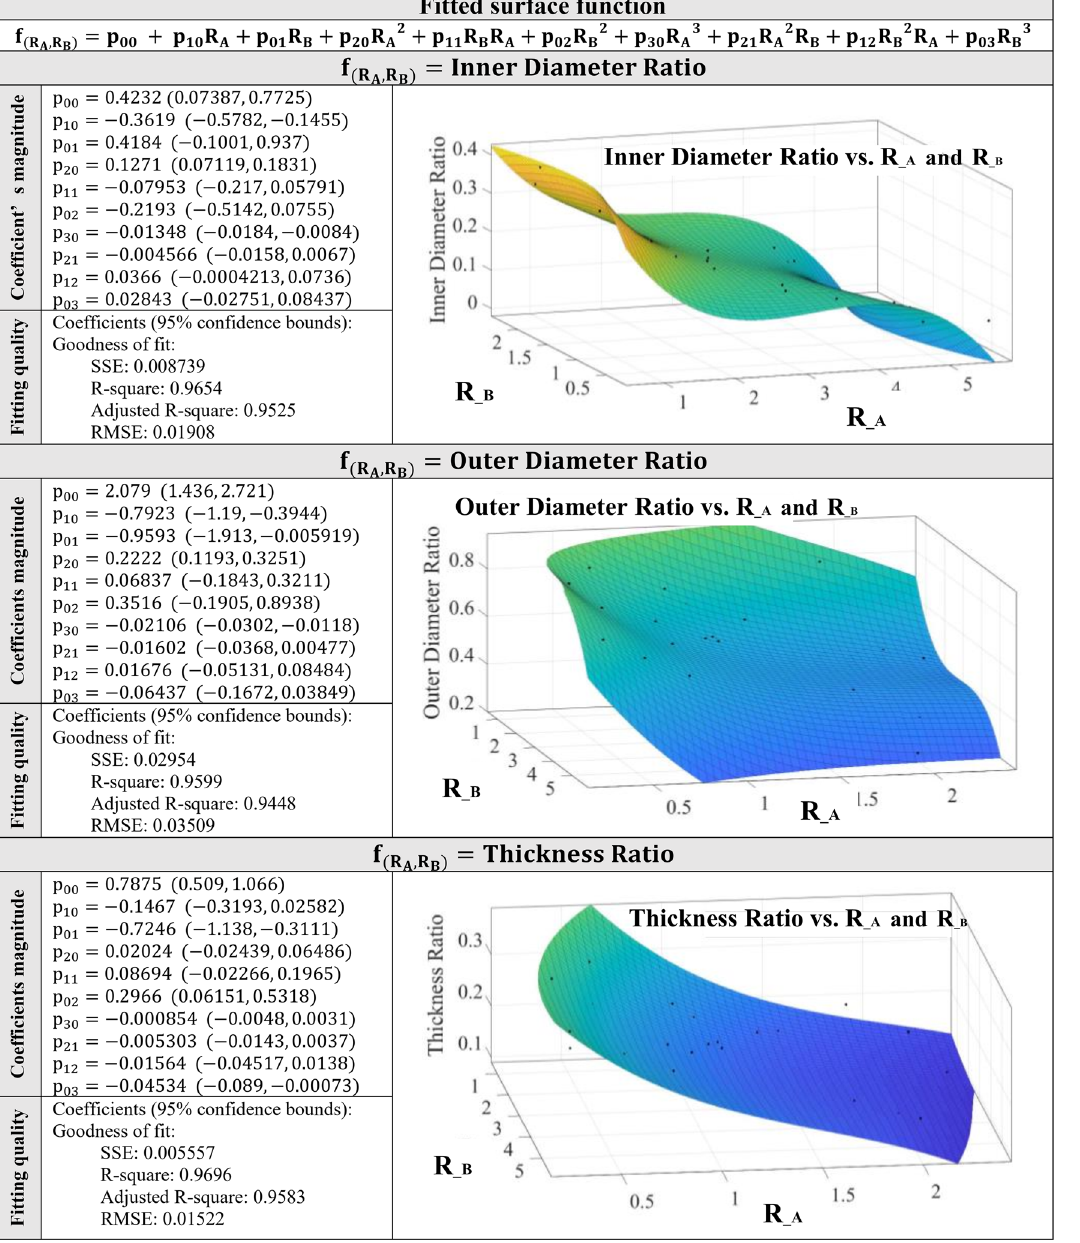
Figure 5. The prediction equation of inner/outer diameter ratio and wall thickness ratio based on R B and R A Solid microfiber. Although the microfluidic system design for the fabrication of hollow versus solid microfiber appears to be different, there exist identifiable similarities. If channel C of the hollow microfiber is blocked, then the result would be a microfluidic system that is capable of the fabrication of solid microfiber. Akin to the simula- tion for the hollow microfiber, the flow rate plays a significant role in controlling the geometrical properties of the fabricated solid microfiber. Figure 6a shows the phase boundary field output of the solid microfiber fabri- cated inside the microfluidic channel. Herein, the ratio of the sheath flow rate to the sample flow rate is observed to be directly related to the diameter of the solid microfiber. Besides, the viscosity and channel diameter have a significant effect on the diameter of solid microfiber. Furthermore, based on the comparison between the solid microfiber diameters output in the numerical simulation and the experimental diameter values of calcium alginate 3 in Fig. 6b, the magnitude and the decreasing trend of the microfiber diameter are the same. This figure shows that the error value of numerical and experimental values is less than 10.5%. Therefore, the numerical model accuracy is acceptable while it can be improved. So, like the hollow microfiber, a dimensionless number R A which is defined as the ratio of channel B flow Reynold’s number over channel A flow Reynold’s number, is a criterion that specifies the droplet formation regime in the sample fluid. Also, this variable can be leveraged to correlate the diameter of fabricated microfiber and